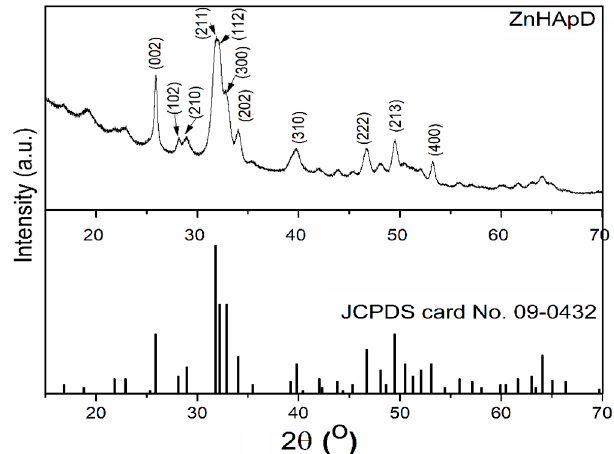
Figure 8. X-ray diffraction (XRD) pattern of the synthesized dextran-coated zinc-doped hydroxyapatite (ZnHApD) sample and the standard pattern of pure hexagonal HAp (JCPDS card No.09-0432).